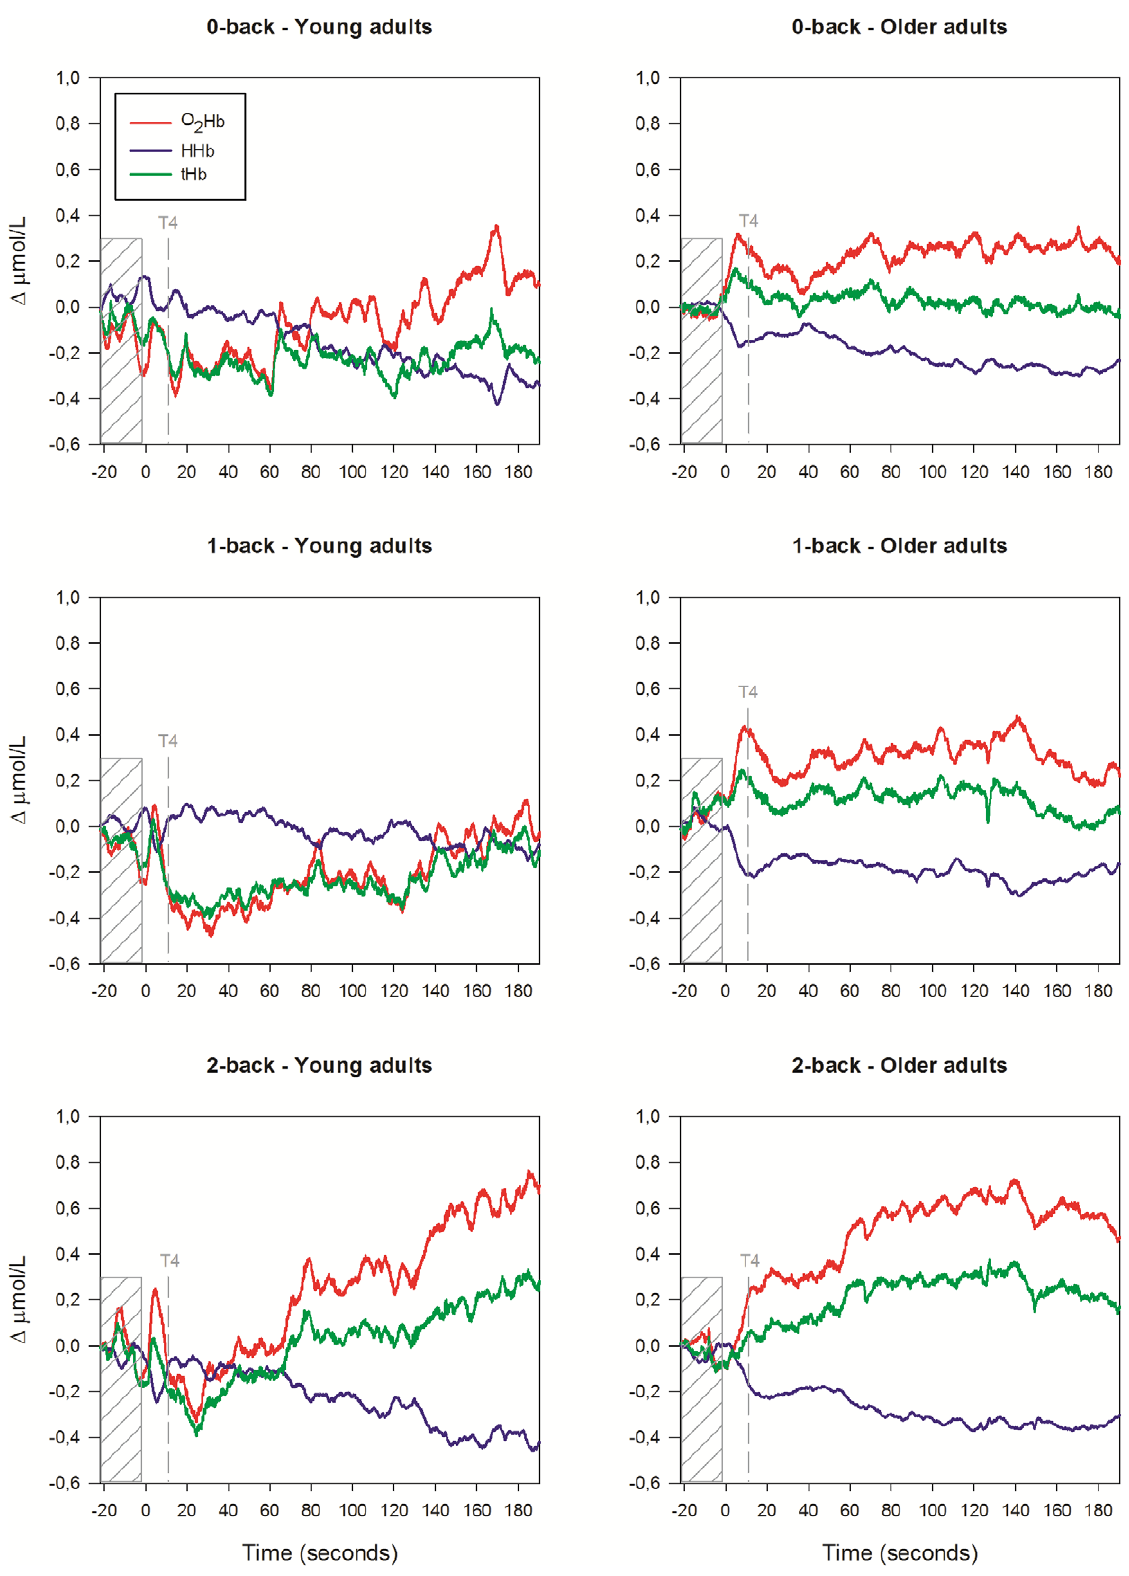
Figure 3. Grand average waveforms of [O 2 Hb], [HHb] and [tHb] changes in the prefrontal cortex. The Figure shows raw fNIRS signals of young and older adults during performance of the verbal 0-back task ( upper panels ), 1-back task ( middle panels ) and 2-back task ( lower panels ). The last 20 s of the pre-task baseline period are marked in the Figure. The n-back task starts at 0 s. The first three trials were excluded from further data analysis. The start of the fourth trial has been marked by the dashed line (T4). For illustrative purposes, in this Figure the signals were nulled at 2 22 s and were averaged over the left and right optode pair. doi:10.1371/journal.pone.0046210.g003 PLOS ONE | www.plosone.org